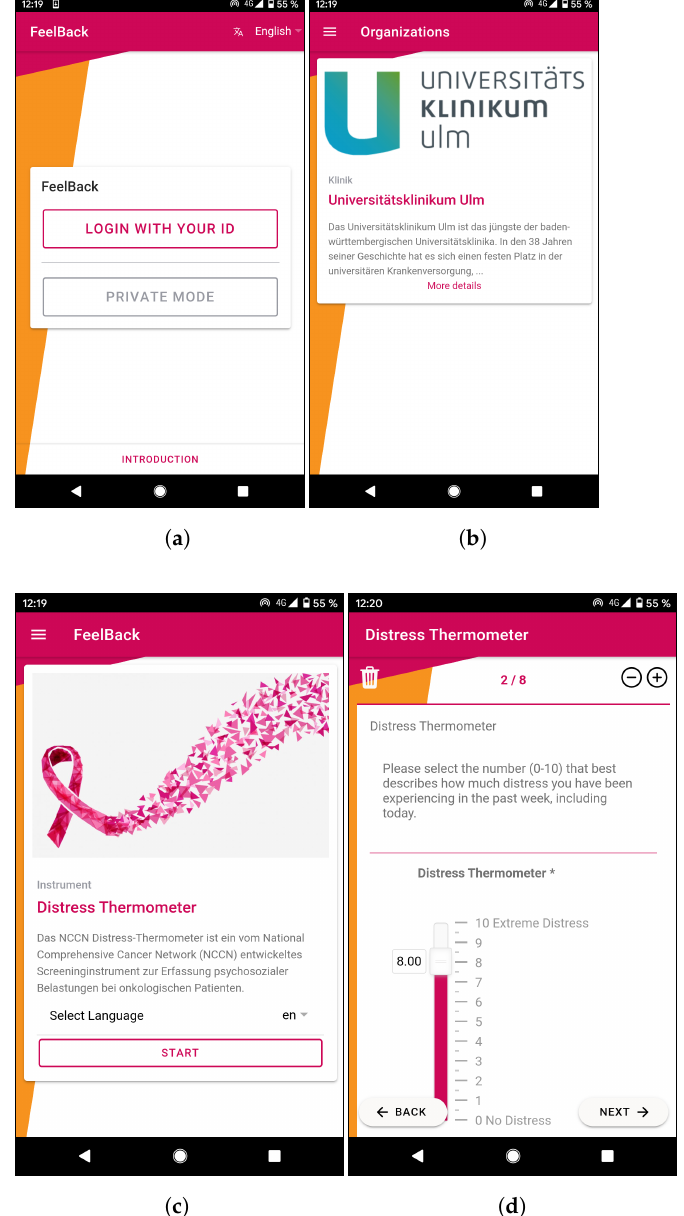
Figure 4. Screenshots of the Mobile Data Collection Application within the FeelBack platform. ( a ) Shows the login screen of the FeelBack application. Users can access the application via their respective ID. ( b ) Depicts an exemplary overview about the registered organizations. Here, it is showing general information and contact details for Ulm University Hospital as health care provider. ( c ) A screenshot of the home screen of the FeelBack application. From here, a user can access settings via the upper menu or start to report the current psychological condition via a implemented questionnaire. ( d ) Here, the Distress Thermometer by the National Comprehensive Cancer Network is used. The amount of distress can be entered via answering the respective